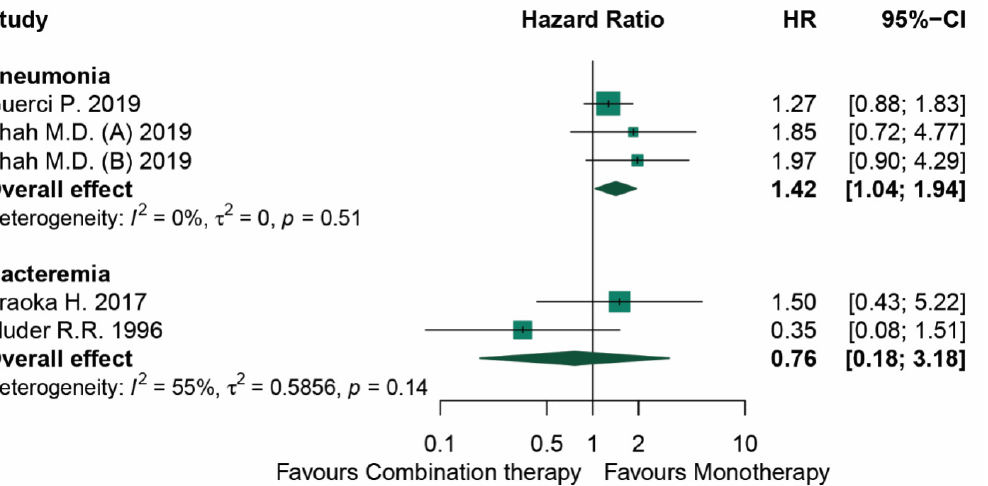
Figure 2. Forest plot presenting the HRs of mortality of patients with S. maltophilia infections compared between combination therapy and monotherapy [25,26,27,28].